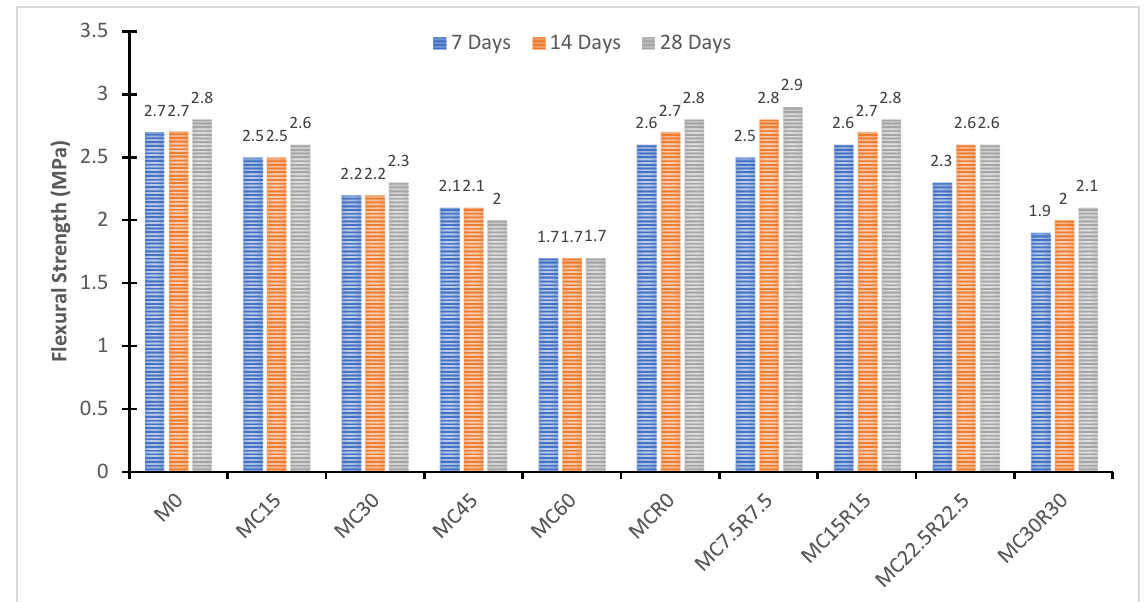
Figure 6. Test setup for flexural strength.